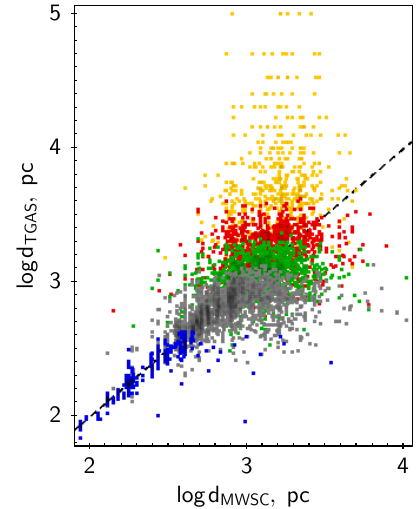
Figure 2. Comparison of photometric (MWSC) and trigonometric (TGAS) distances of probable cluster members: yellow dots show stars with ε / ϖ ≥ 1; red dots 0.5 ≤ ε / ϖ < 1; green dots 0.3 ≤ ϖ ϖ ε ϖ / ϖ < 0.5; grey dots 0.1 ≤ ε ϖ / ϖ < 0.3, and blue dots ε ϖ / ϖ < 0.1. Stars with ϖ ≤ 0 are TGAS